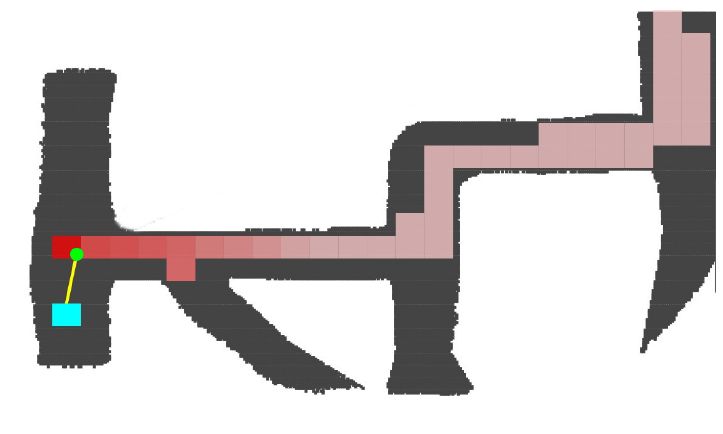
Figure 5. Visited zone